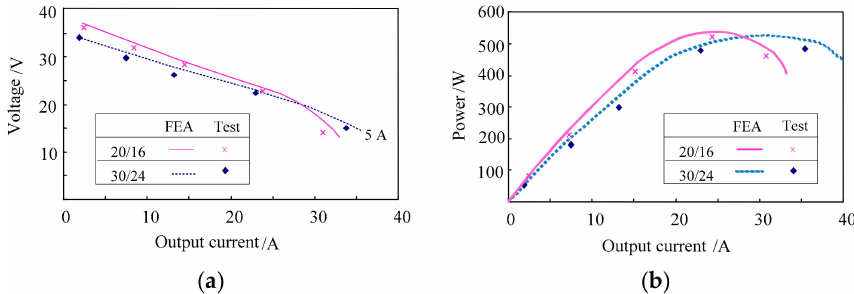
Figure 8. External and output characteristics. ( a ) External characteristics and ( b ) output